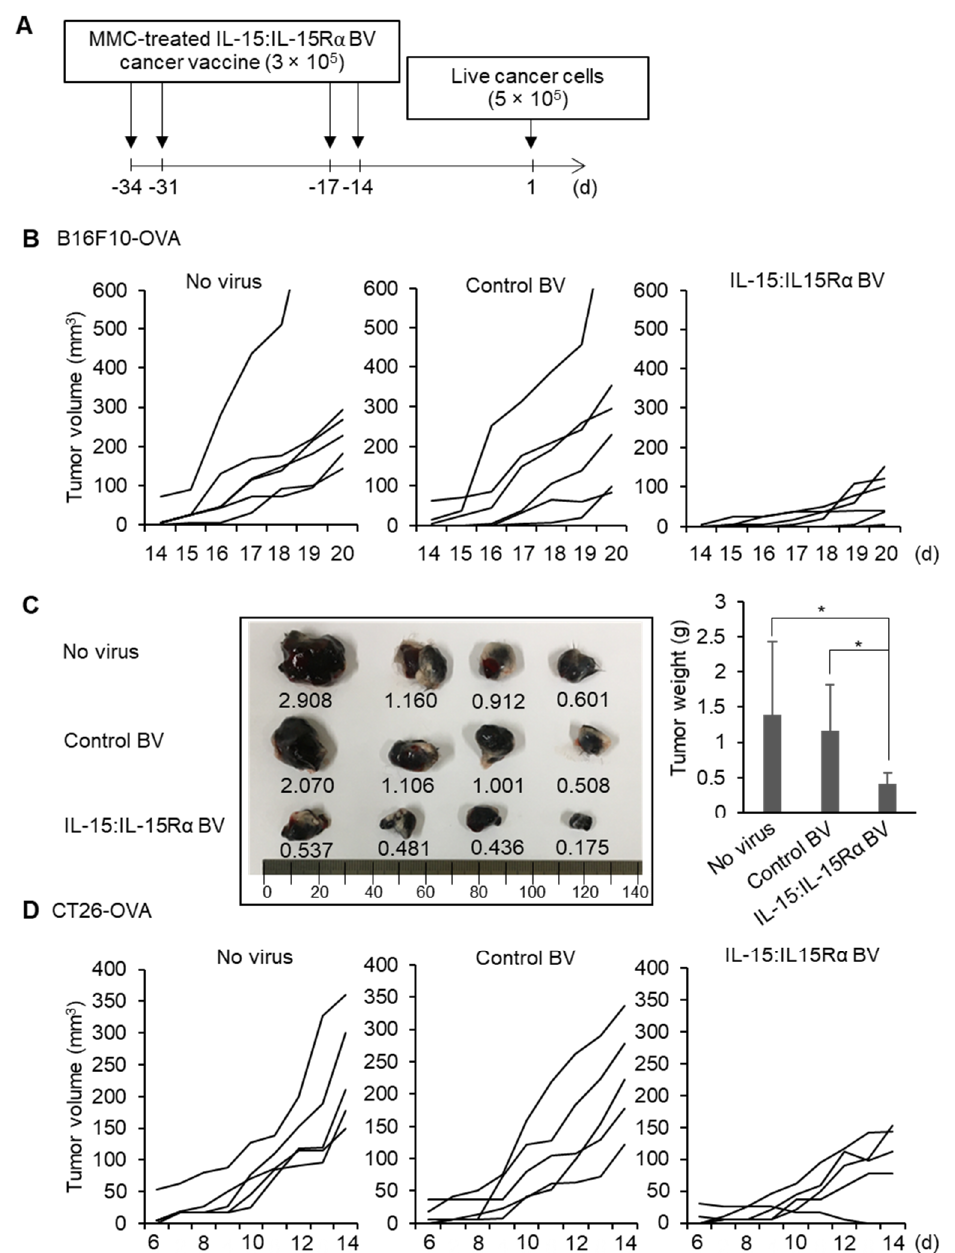
Figure 3. Protective effect of the BacMam-based IL-15:IL-15R α cancer vaccine against B16F10-OVA melanoma and CT26-OVA colon cancer. ( A ) Optimal vaccination schedule; BacMam-based cell-based cancer vaccines were prepared by infecting B16F10-OVA or CT26-OVA cells with IL-15 BV + IL-15R α BV at the total MOI of 8 or 16. Then, mice were subcutaneously vaccinated with IL-15:IL-15R α -B16F10-OVA or IL-15:IL-15R α -CT26-OVA (3 × 10 5 cells/mouse) in the right flank after MMC inactivation of the cells on the indicated days. Two weeks after the last immunization, the immunized mice were subcutaneously challenged with either B16F10-OVA or CT26-OVA cancer cells (5 × 10 5 cells/mouse) in the left flank. ( B , C ) Protective effect of the BacMam-based OVA cell-based cancer vaccine against B16F10-OVA melanoma in C57BL/6J mice ( n = 6). Tumor growth curves of B16F10-OVA cells in the C57BL/6J mice vaccinated with IL-15:IL-15R α -B16F10-OVA (IL-15:IL-15R α BV), control-B16F10-OVA (control BV), or non-infected B16F10-OVA cells (no virus) ( B ). Typical tumor samples (left) and the average tumor weights at day 22 (right) ( C ). ( D ) Tumor growth curves of CT26-OVA cells in the BALB/c mice vaccinated with IL-15:IL-15R α -CT26-OVA (IL-15:IL-15R α BV), control-CT26-OVA cells (control BV), and non-infected CT26-OVA cells (no virus) ( n = 5). Note: * p <